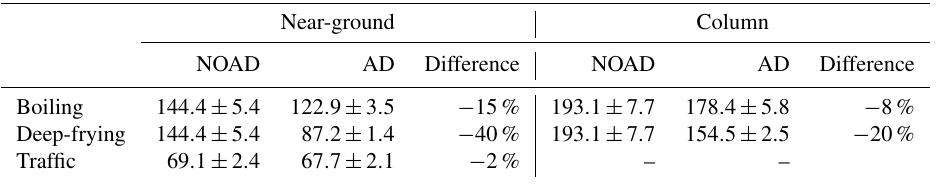
Figure 4. Vertical profiles of the normalised mean streamwise velocity, (cid:104) u (cid:105) / (cid:104) U s (cid:105) , for the present LES and wind-tunnel measurements (Brown et al., 2001). (cid:104) U s (cid:105) is the average streamwise velocity within the shear layer (1 ≤ z/H ≤ 1 . 5). The LES results are plotted with blue lines and the wind-tunnel data with red circles. Table 2. Canyon-averaged dimensionless concentrations, (cid:104) N (cid:105) c , for the near-ground (Fig. 6) and column (Fig. 7) cooking emissions. The errors correspond to the spatial standard deviation; the relative change in the mean concentrations is also listed. Both the mean and standard deviation are